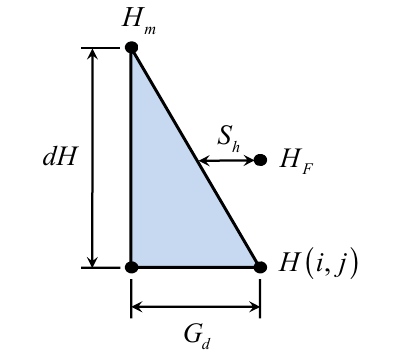
Figure 1. The example diagram of Equation (1).